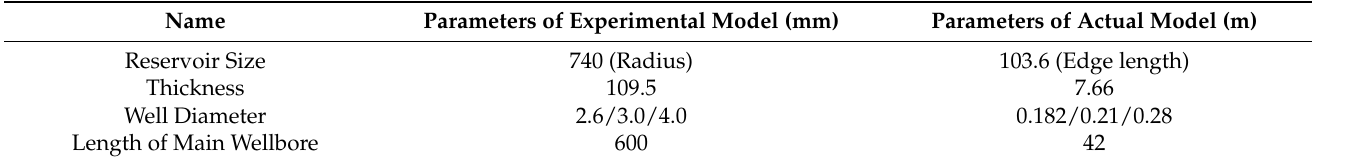
Table 2. Comparison between the experimental model and the corresponding actual model